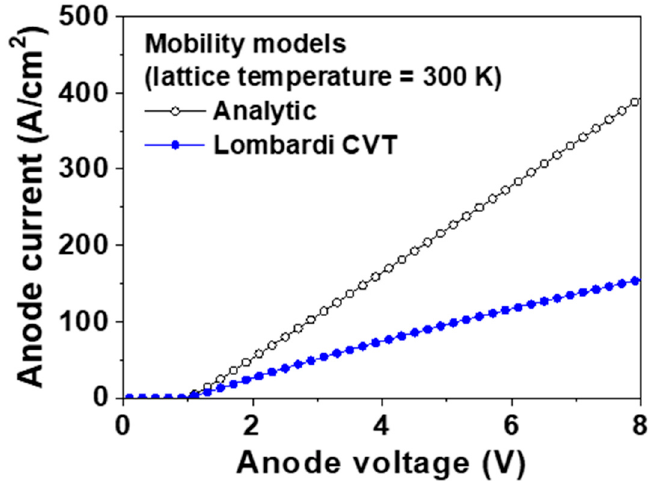
Figure 4. Forward current–voltage (I–V) characteristics of the p-type diamond pseudo-vertical Schottky barrier diode (SBD) simulated using the analytic and Lombardi mobility models, respectively. The metal work function, hole saturation velocity, and lattice temperature were 5.65 eV, 2.7 × 10 7 cm / s, and 300 K, respectively.